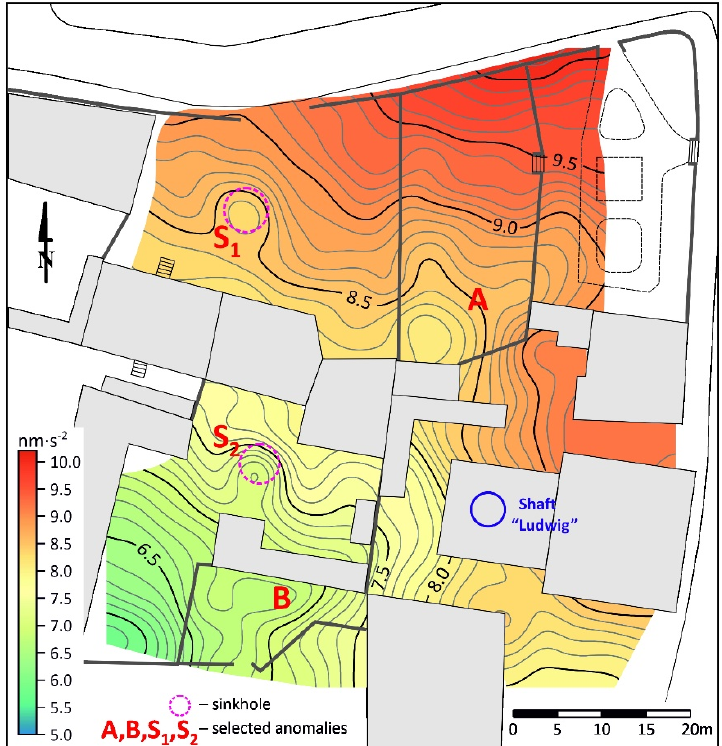
Figure 10. Distribution of Bouguer anomalies with corrections.